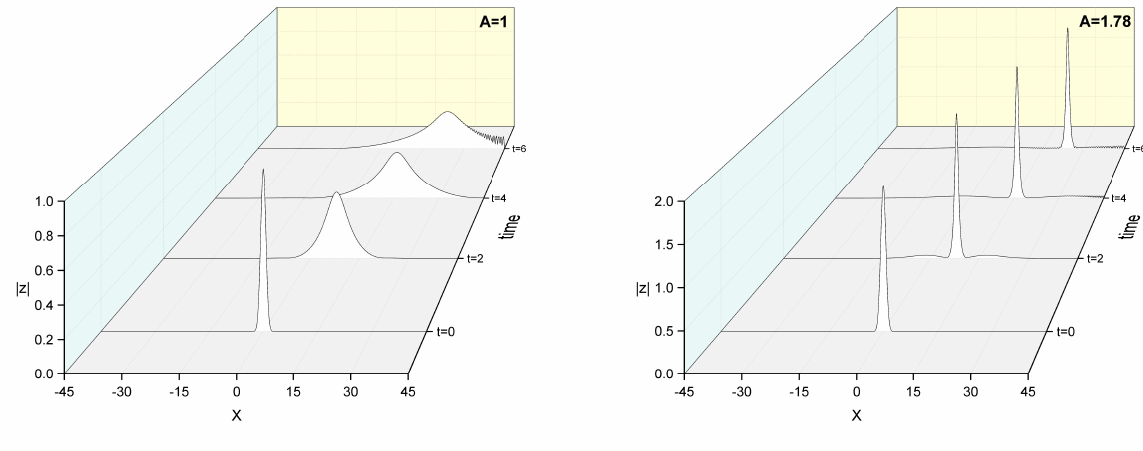
Figure 4. The mobile soliton: A = 1 , A = 1 . 78 . Table 9. Invariants of mobile soliton:A=1.